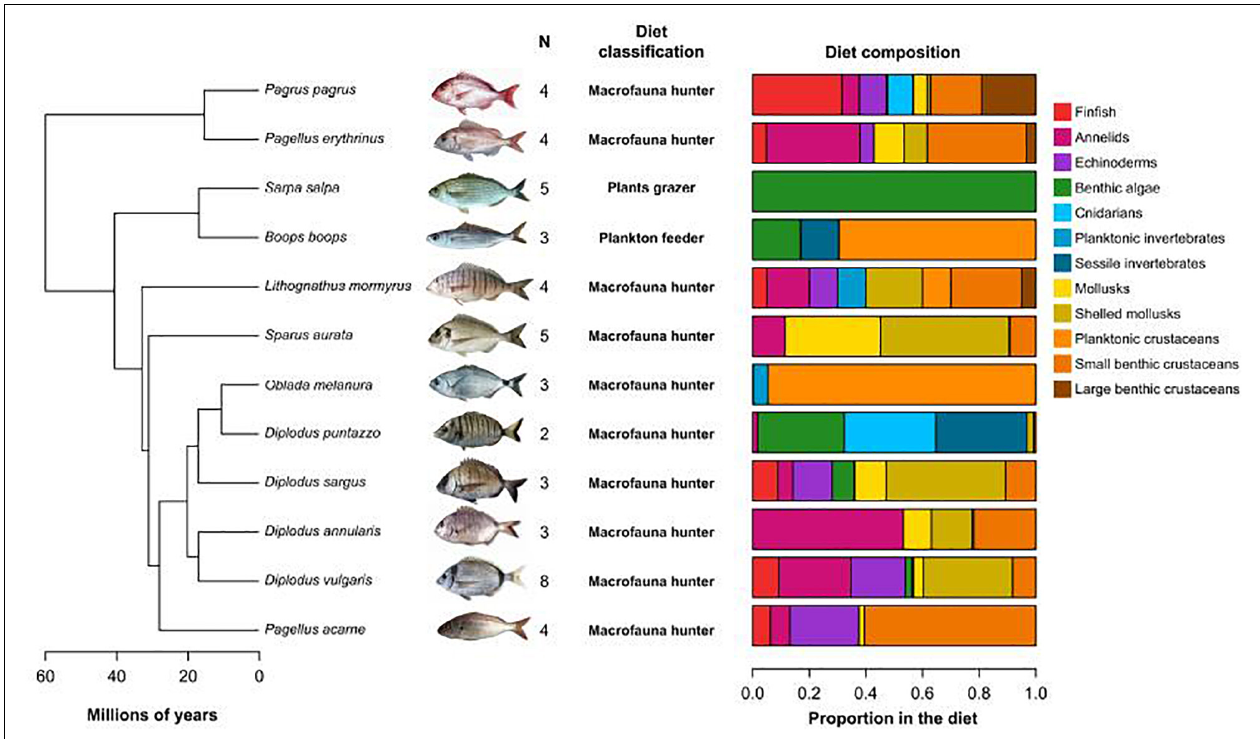
FIGURE 1 | Phylogenetic relatedness and diet of the 12 studied species. Phylogeny of the Sparidae used in this study (from Santini et al., 2014). N is the number of individuals analyzed per species. Diet classification and proportions of food items in the diet were collected in